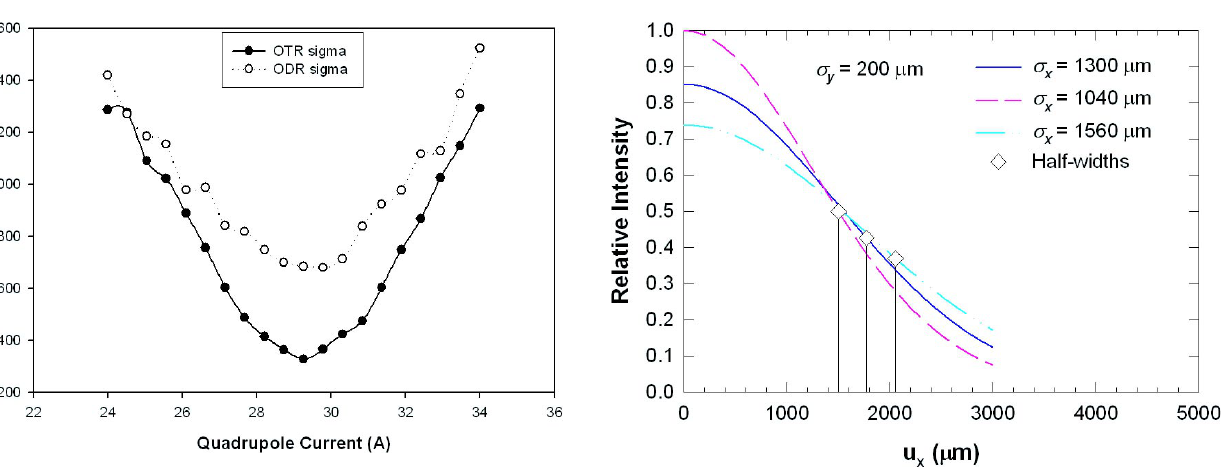
FIG. 11. (Color) Analytical model results for the effects on the unpolarized ODR horizontal profiles for a variation of the beam size by (cid:7) 20% around the 1300- (cid:2) m value with d (cid:5) 1000 (cid:2) m .